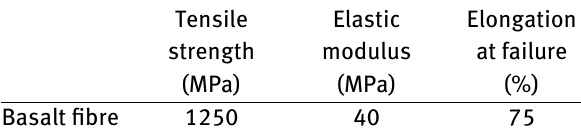
Table 2: Mechanical properties of basalt fibres